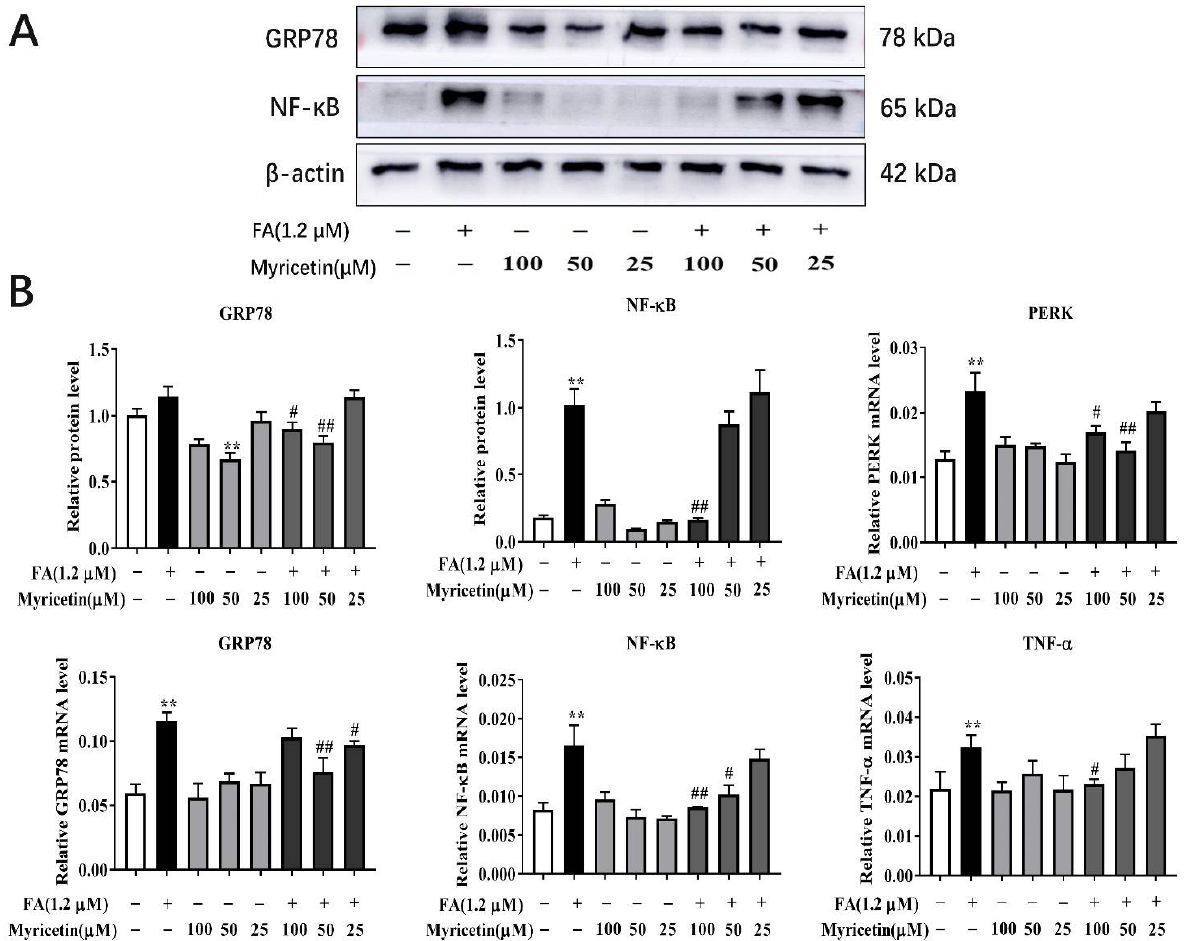
Figure 4. The effect of myricetin on the key protein and mRNA associated with endoplasmic reticulum stress and inflammation. Hepatocytes were treated with 100 μM (M1), 50 μM (M2), 25 μM (M3), or RPMI-1640 basic medium (Control) with or without 1.2 mM FA. ( A ) Representative Western blot of GRP78 and NF-κB. ( B ) Protein abundance of GRP78 and NF-κB, and relative mRNA abundance of PERK, GRP78, NF-κB, and TFN-α. Data were analyzed using a two-way repeated-measure (RM) ANOVA with subsequent Bonferroni correction. The data presented are the means ± SEM; ** p < 0.01 indicate differences from the control. # p < 0.05, ## p < 0.01 indicate differences from the cells incubated with FA.